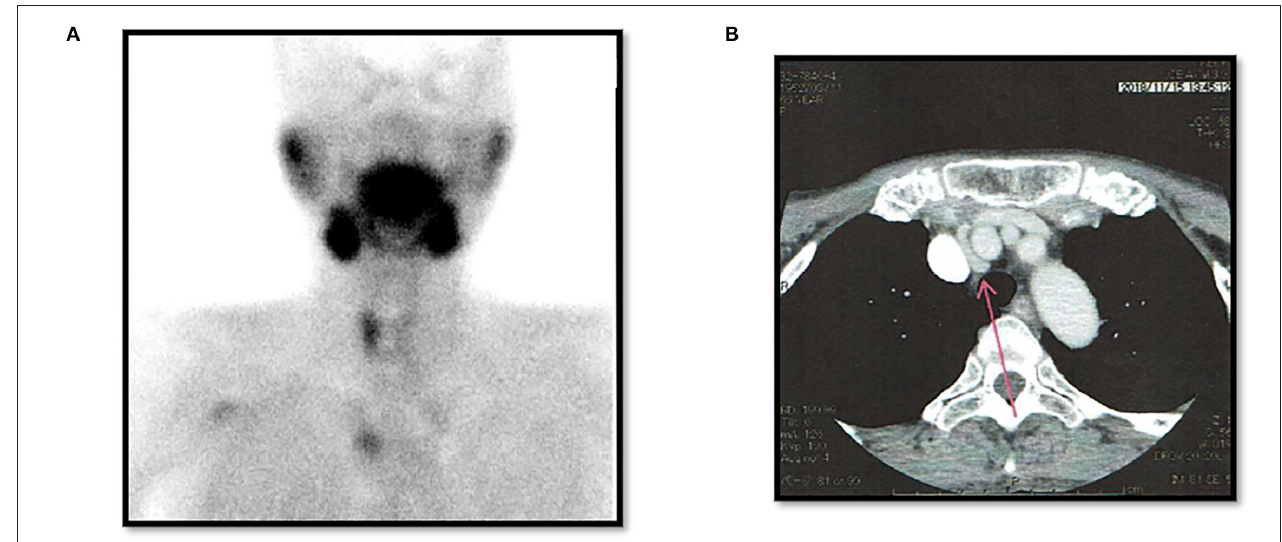
FIGURE 3 | Case 3. Post-operative left thyroidectomy. (A) 99m Tc-MIBI (late phase) showing a right thyroid mass and anterior mediastinal washout staining (EPA). (B) Thoracic enhanced CT scan showing a mass between the right brachiocephalic artery and superior vena cava (EPA: red arrow).